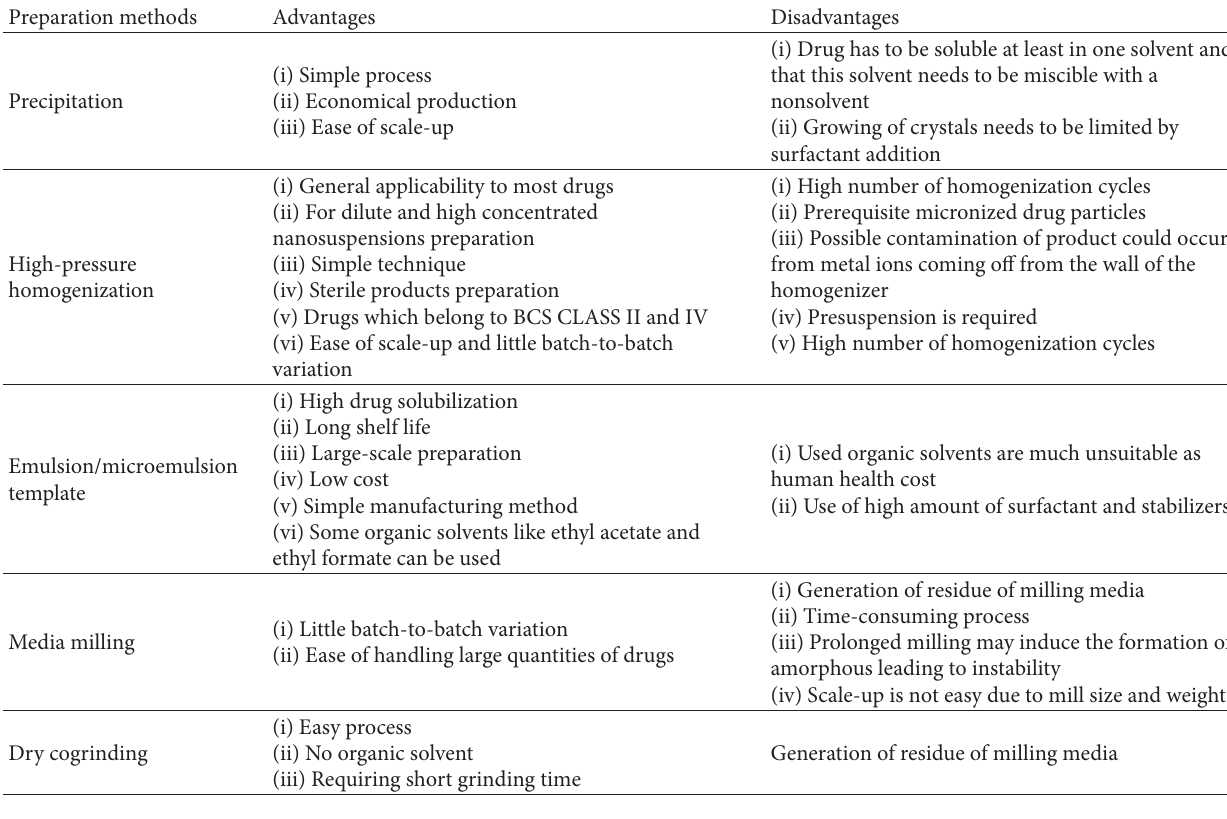
Table 1: Advantages and disadvantages of different preparation methods of nanosuspension technologies [7, 13, 17,